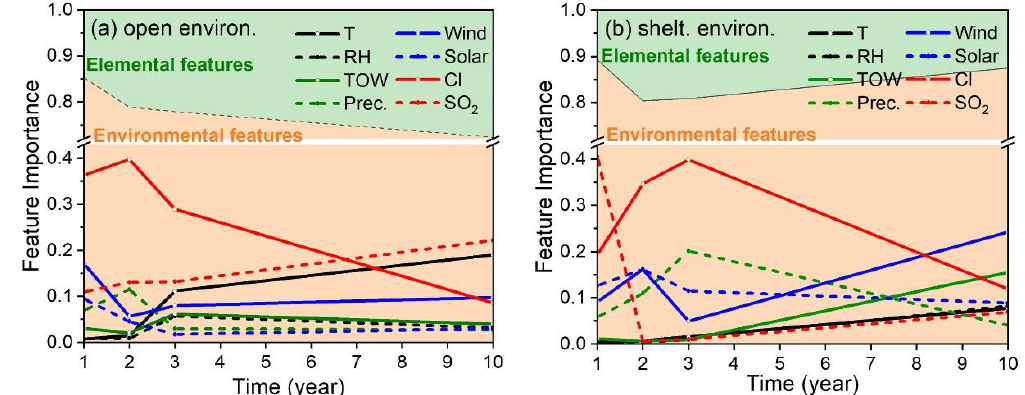
Figure 3. Stacked area charts of elemental and environmental feature importance, and line plots of individual environmental features. The feature importances derived from the random forest models were established on the basis of steel samples in 1-, 2-, 3- and 10-year exposure tests under the ( a ) open and ( b ) sheltered environment.